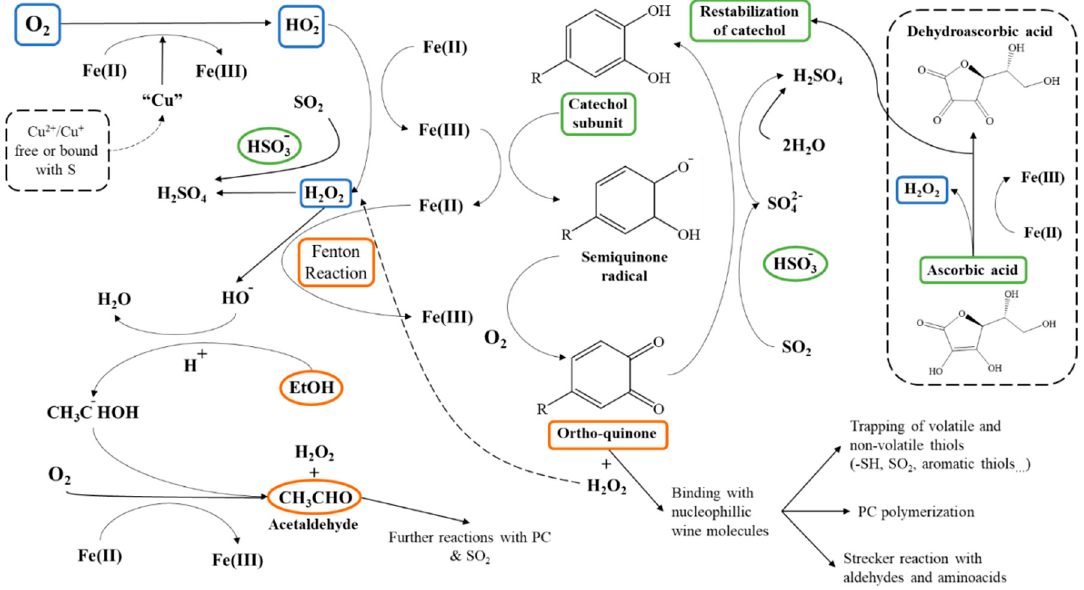
Figure 2. Overview of chemical interactions between SO 2 , metallic ions, quinones and induced subsequent reactions. Ethanol is the main alcohol of wine that reacts to acetaldehyde. Peroxide resulting from the oxidation of ortho-quinones further contributes to formation of acetaldehyde. Ascorbic acid will act as antioxidant and re-stabilizer of catechol subunits until depletion. Adapted [72–74].